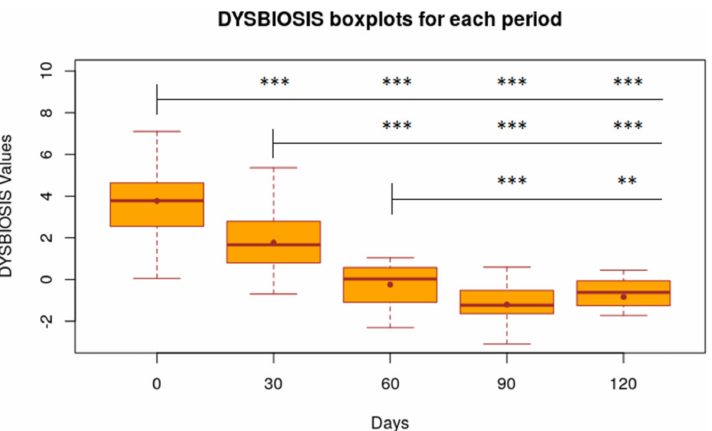
Figure 5. Statistical results of dysbiosis index calculated for each period Boxplot of FeSc value of 32 dogs at time 0, 30, 60, 90, 120 days. Level of Significance compared to time 0, 30 and 60 days: *** 1%; ** 5%; *